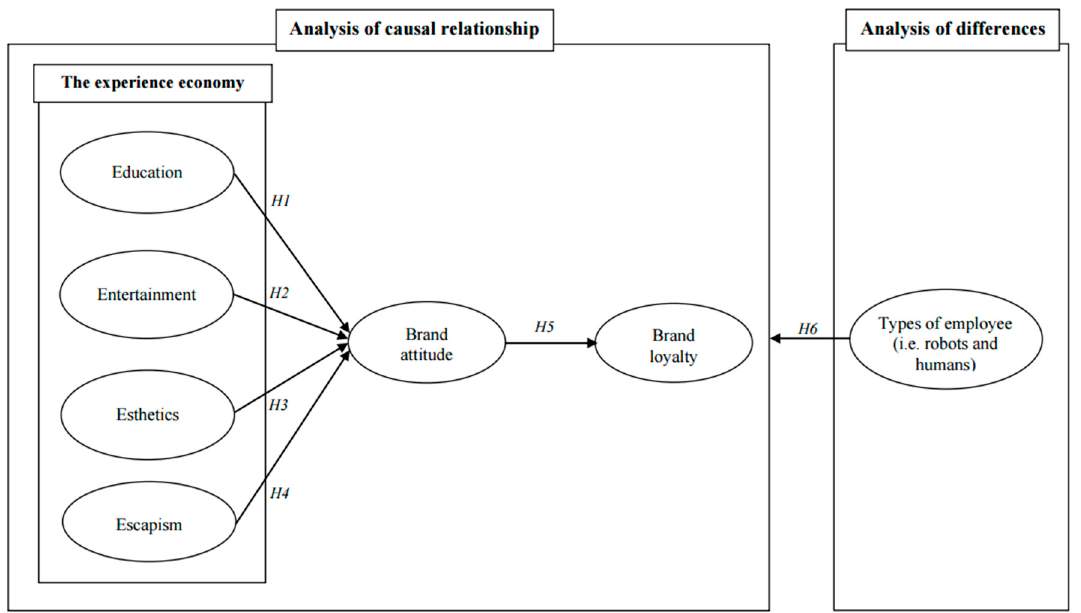
Figure 1. Proposed conceptual model. Notes: H =